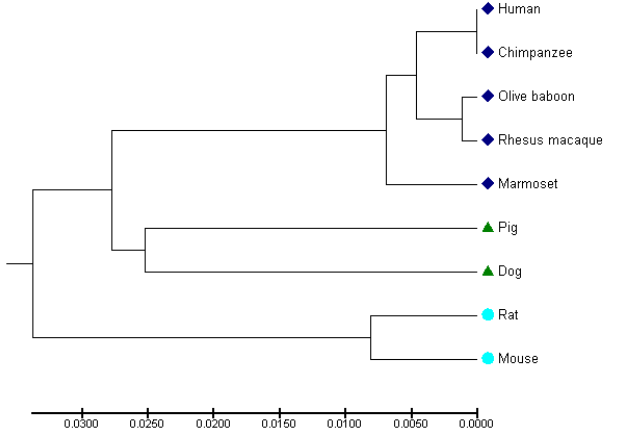
Figure 6. Dendrogram illustrating the evolutionary rela- tion of c-CBL across different mammalian species. The graphic representation was generated using MEGA 7 soft- ware (UPGMA method) for c-CBL sequences from human (ENST00000264033), baboon (ENSPANG00000018962), rhe- sus macaque (ENSMMUG00000004761), marmoset